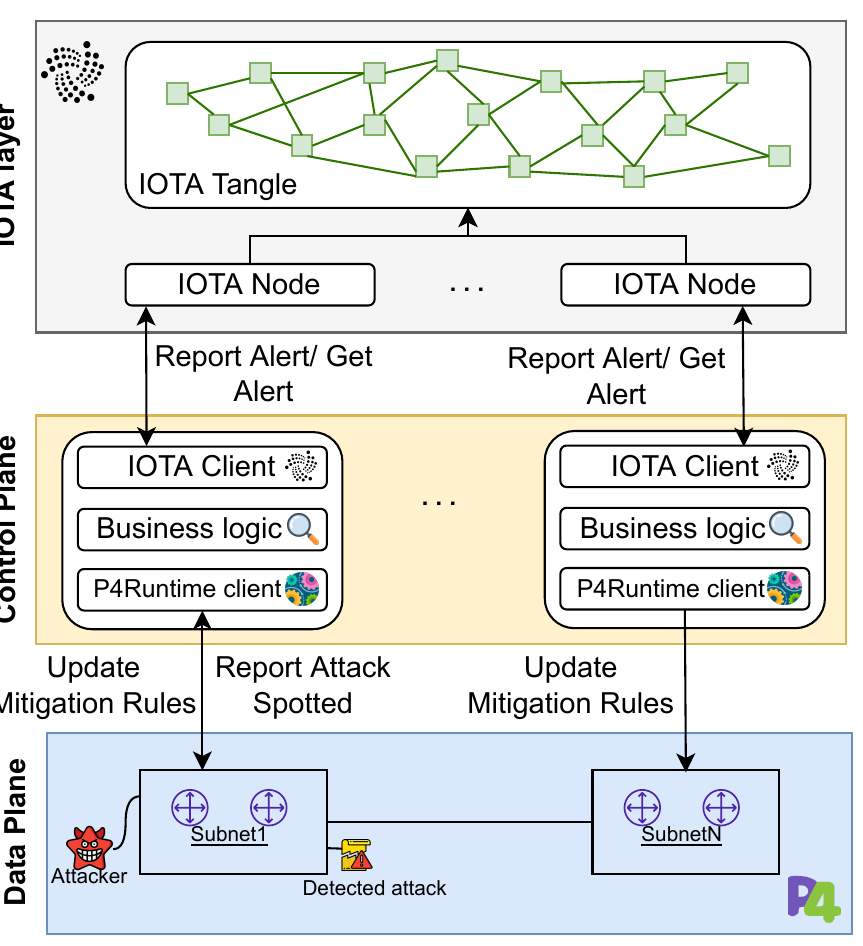
Figure 4. The P-IOTA